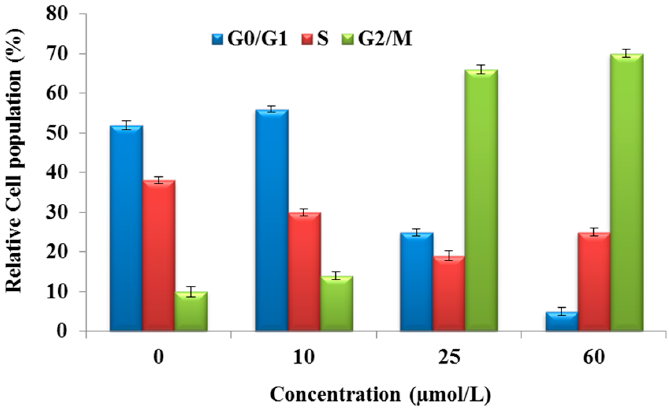
Figure 4. Cell cycle distribution of HepG2 cells with or without treatment with A. spinosus fatty acid at various concentrations after 24 h. The percentage of cells in each phase was estimated by flow cytometry.